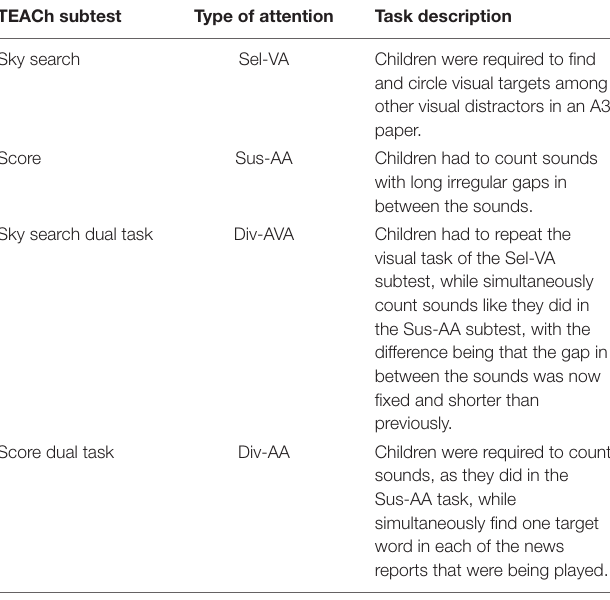
TABLE 2 | The five LiSN-S scores and what they assess (Cameron and Dillon, 2007). LiSN-S score